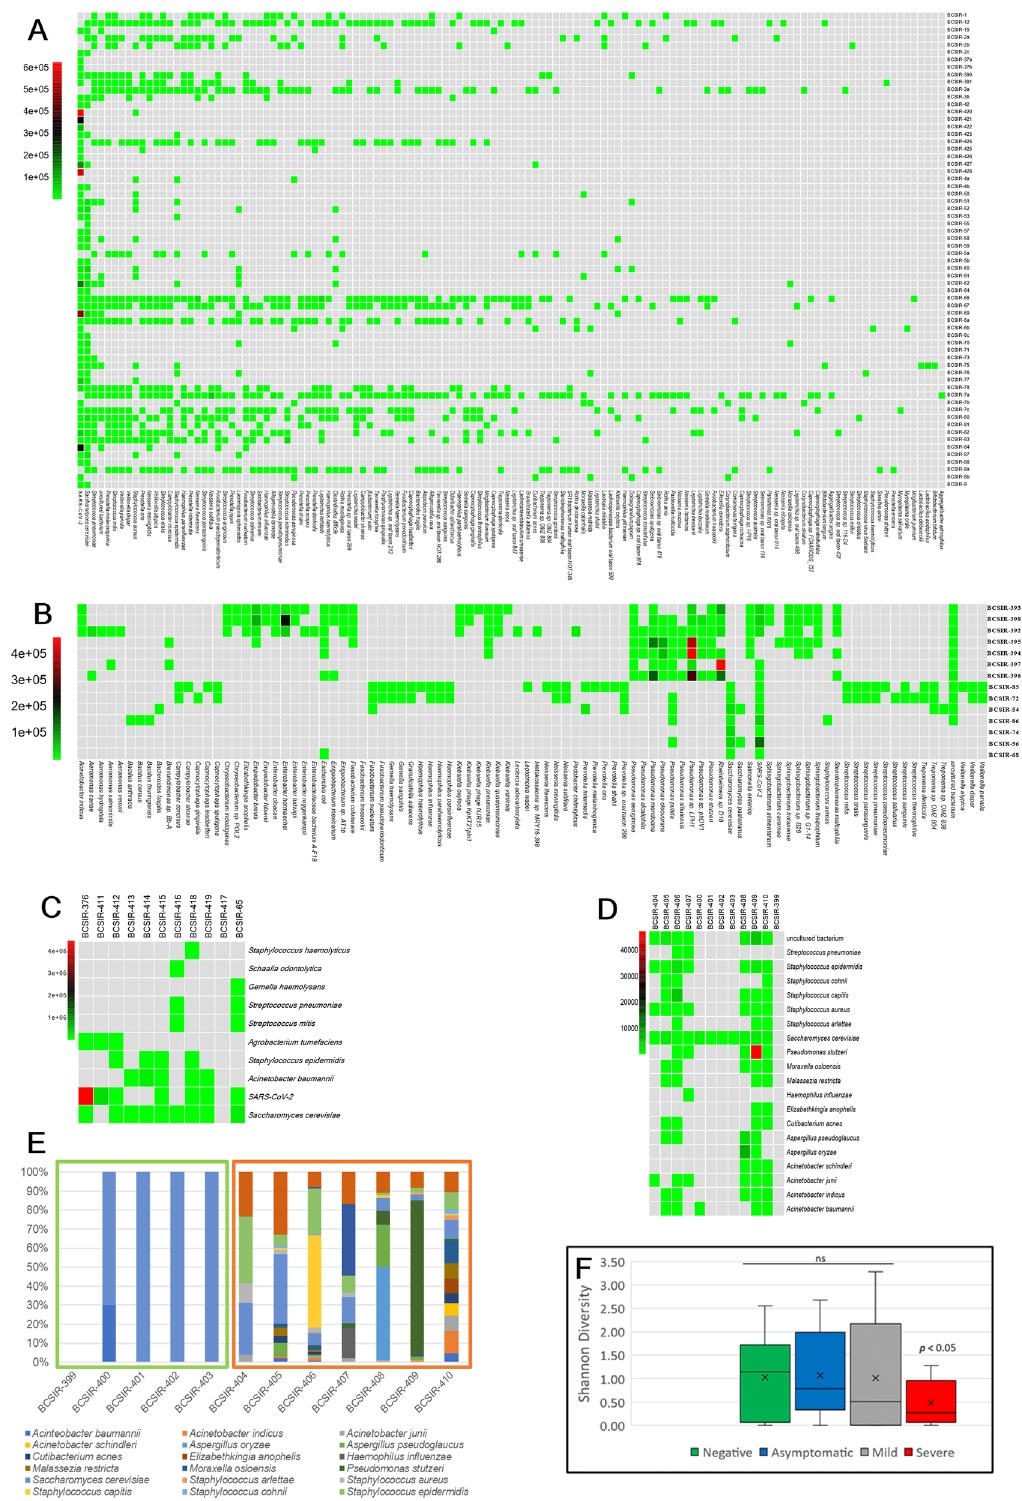
Figure 2. Relative proportions of sequencing reads assigned to species in COVID-19 cohort samples. Heat maps indicate sequences assigned to species identified within ( A ) Mild; ( B ) Asymptomatic; ( C ) Severe; ( D ) Negative cohorts. The heat map was based on the NT rPM values and generated using pheatmap version 1.0.12. The colour coding and range of NT-rPM is indicated to the left of each heatmap ( E ) Stacked plot highlighting taxa identifications in the SARS-CoV-2-negative Never Infected and Recovered cohorts. The light green box indicates Never-infected subjects whilst the orange box indicates Recovered subjects. ( F ) The calculated Shannon diversity index of each cohort. Data was analysed and charts produced in Microsoft Excel version